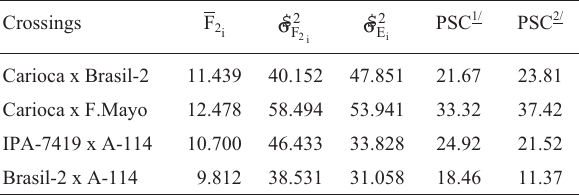
Table VI - Mean yield (F 2i ), in g/plant, and estimates of phenotypic